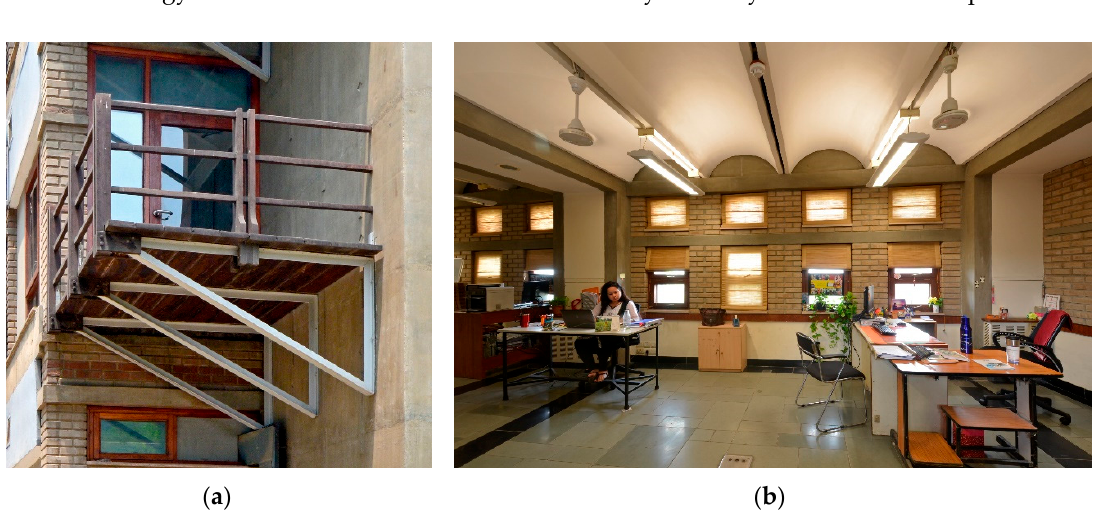
Figure 29. ( a ) Combination of natural and modern materials forming a balcony in the DA building; ( b ) intimate workspaces in the DA building (Photos: Author).